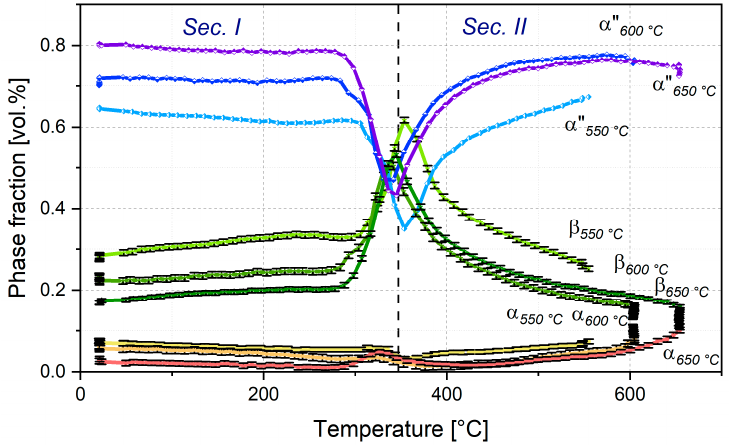
Figure 7. Evolution of α -, β - and α″ -martensite phase fractions during continuous, fast heating (100 K/s) to service temperatures 550, 600 and 650 °C.